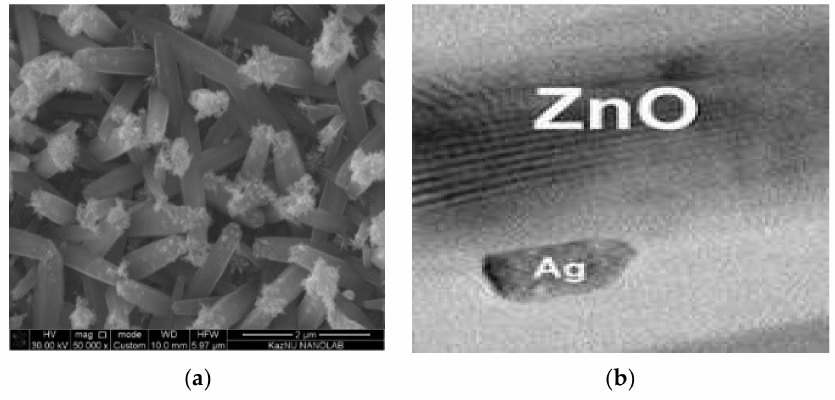
Figure 2. Surface morphology of 1D ZnO/Ag composite material: ( a ) SEM; ( b ) TEM